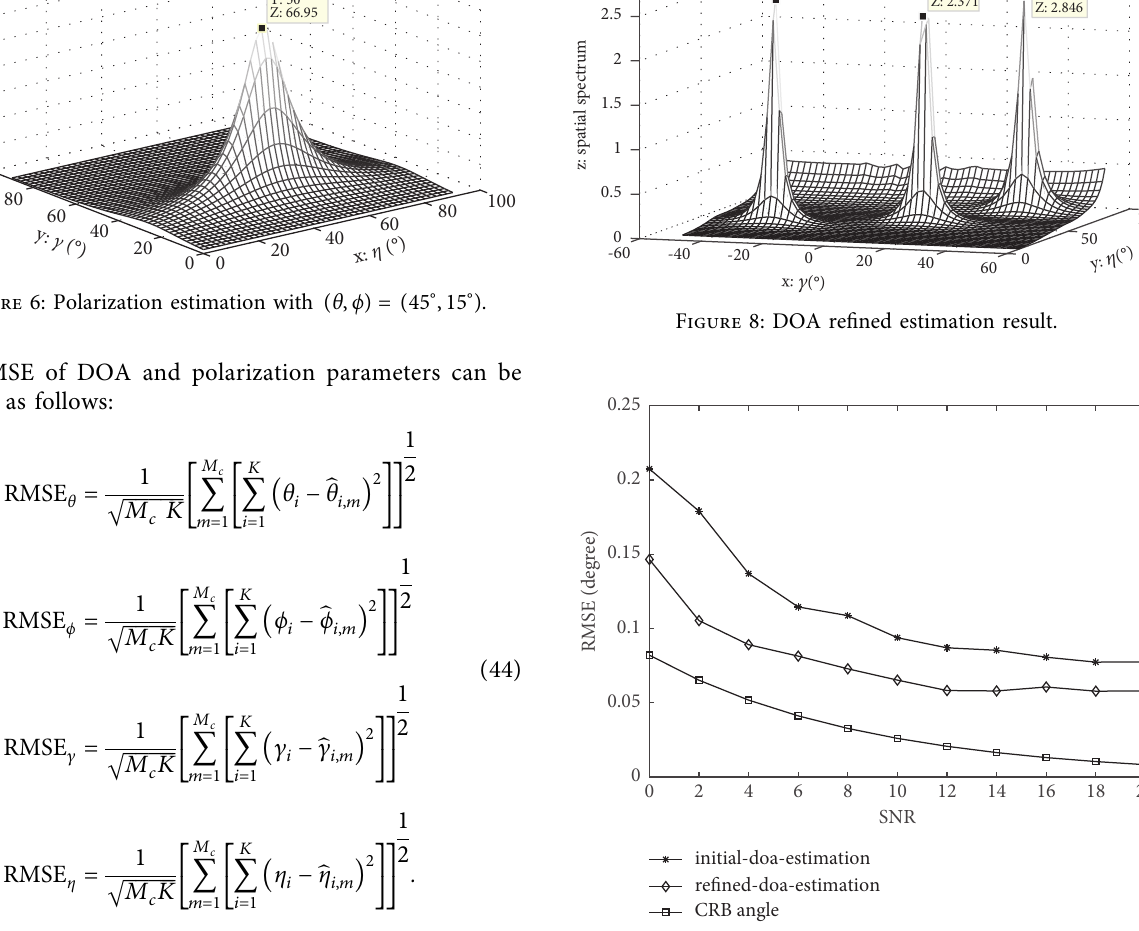
Figure 9: RMSE of DOA with different